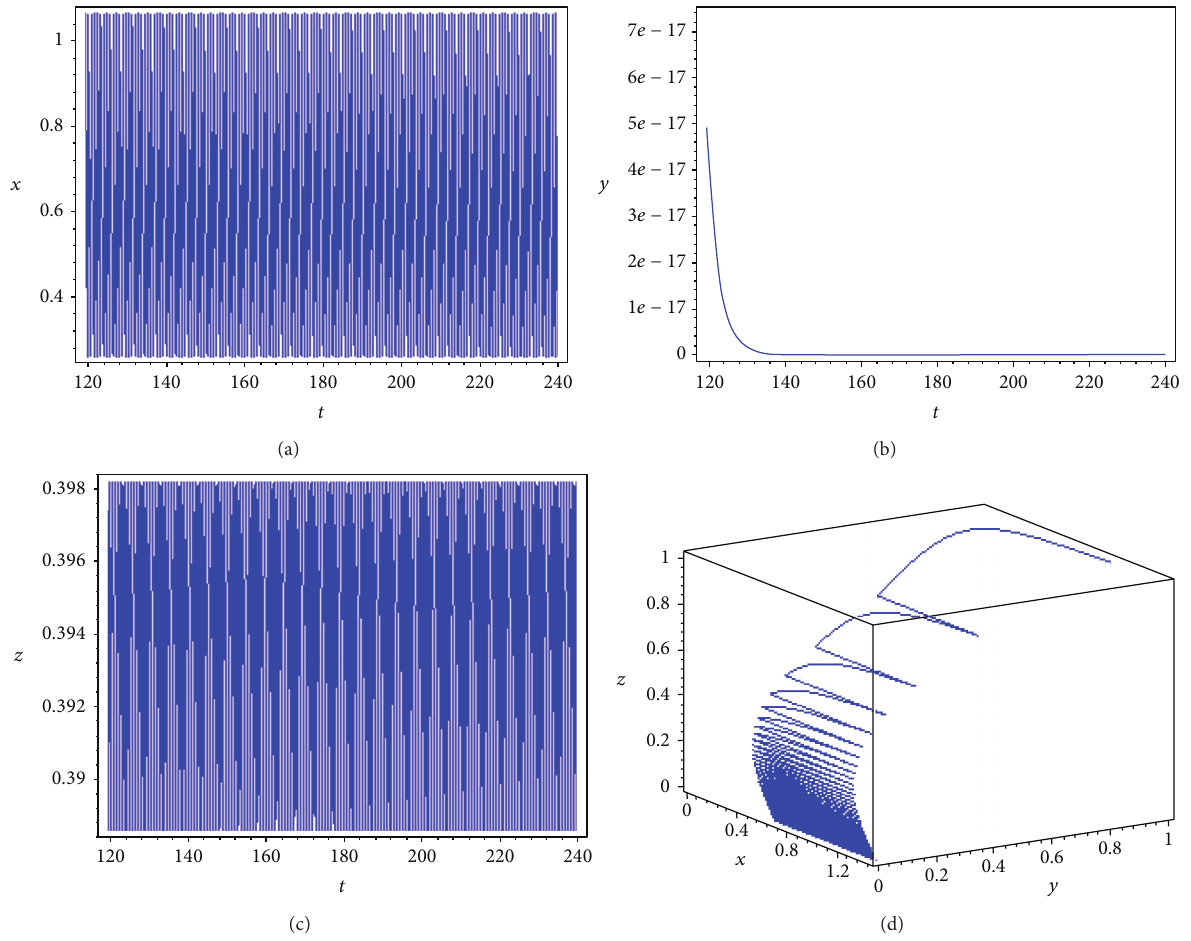
Figure 2: Time series of the system (2) with pulse. 𝑎 1 = 0.2, 𝑎 2 = 0.2, 𝑚 1 = 1.3, 𝑚 2 = 1.5, 𝑞 = 0.2, and 𝑇 = 0.8